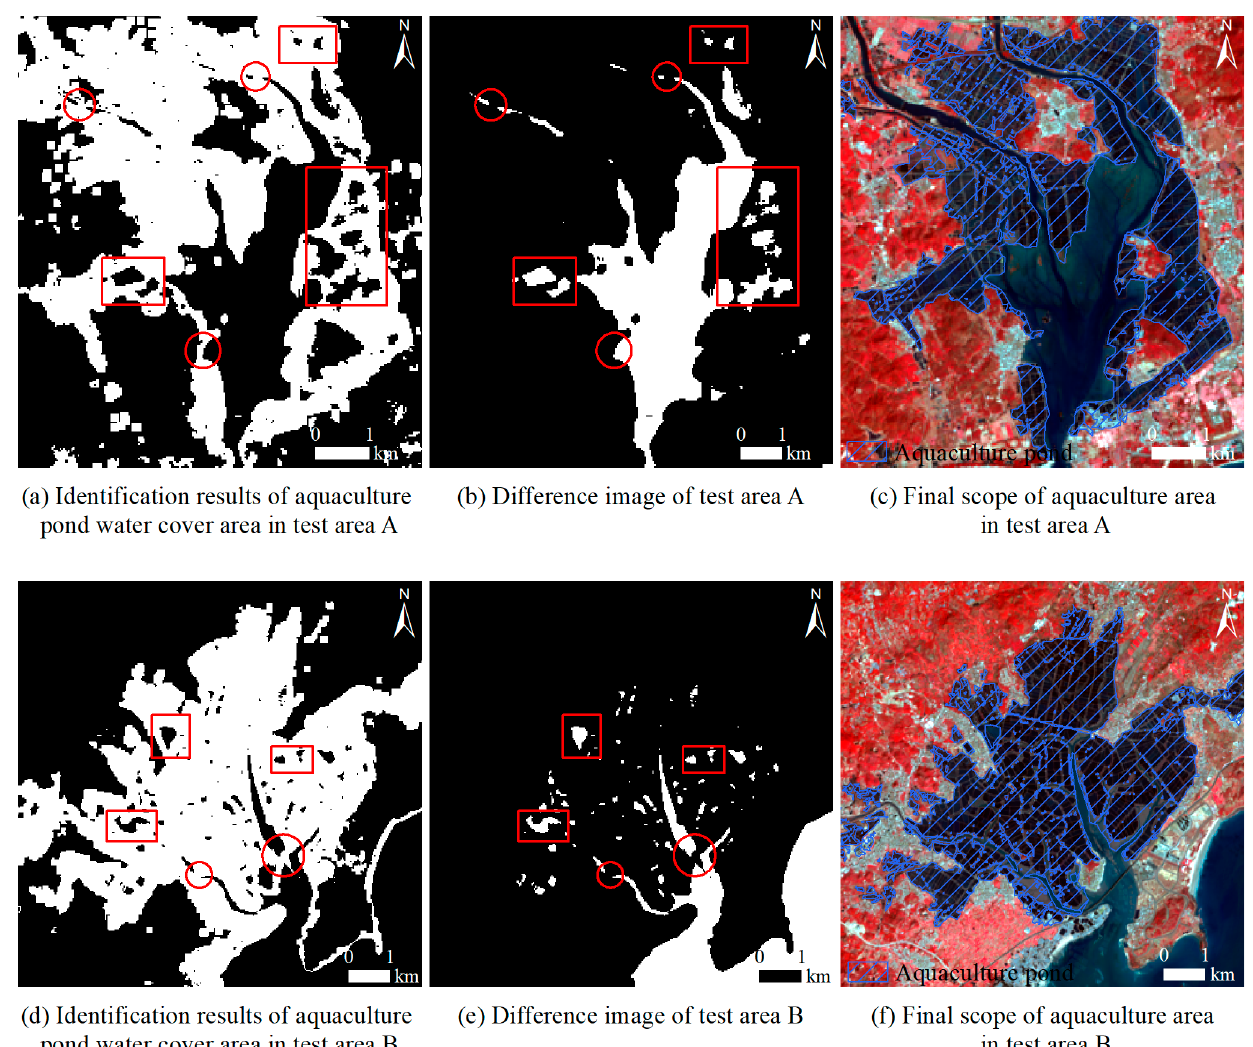
Figure 10. Postprocessing of aquaculture water identification results in the test area A (B).